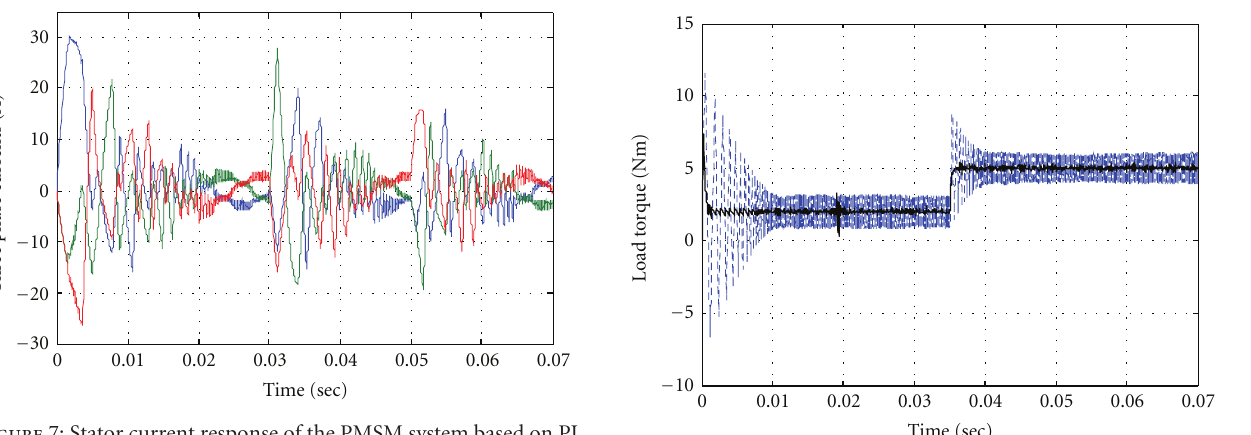
Figure 7: Stator current response of the PMSM system based on PI controller.